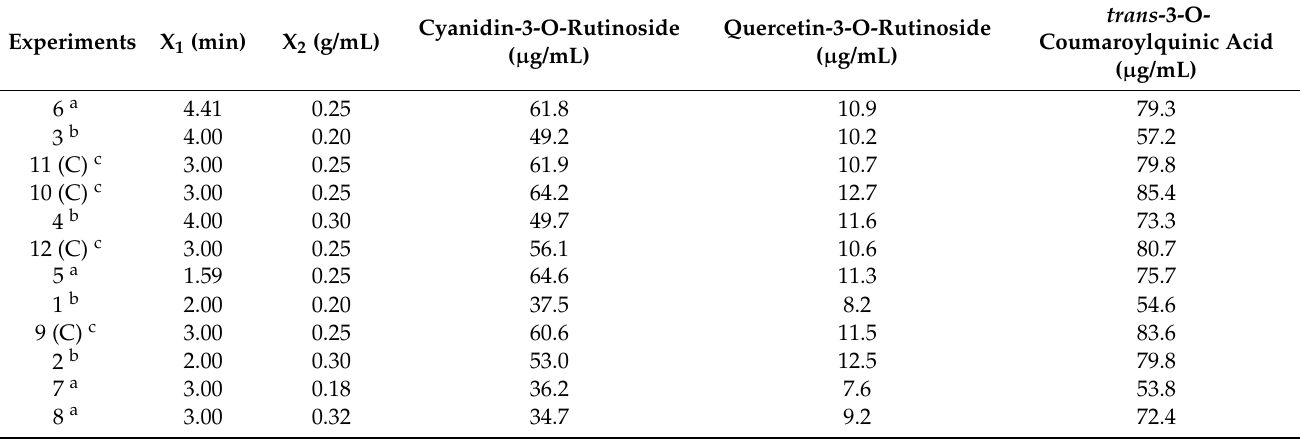
Table 1. UAE optimization by two-level central composite design (CCD).